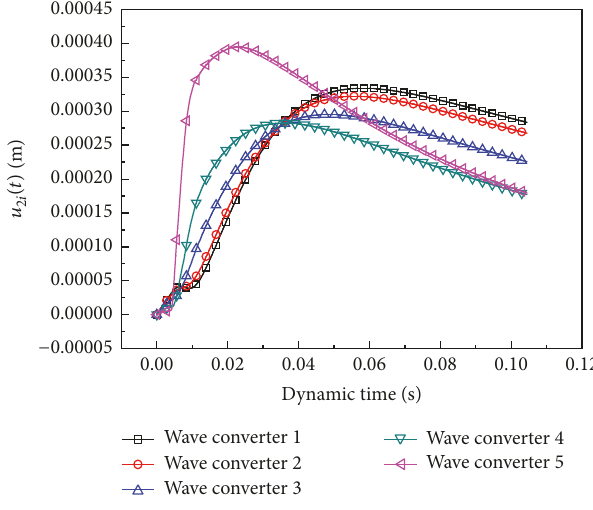
Figure 12: Curves of 𝑢 0𝑖 (𝑡) with time.